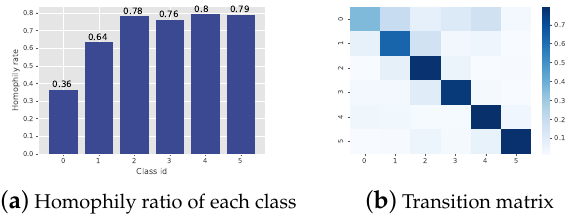
Figure 1. The homophily ratio of each class ( a ) and transition matrix of CiteSeer ( b